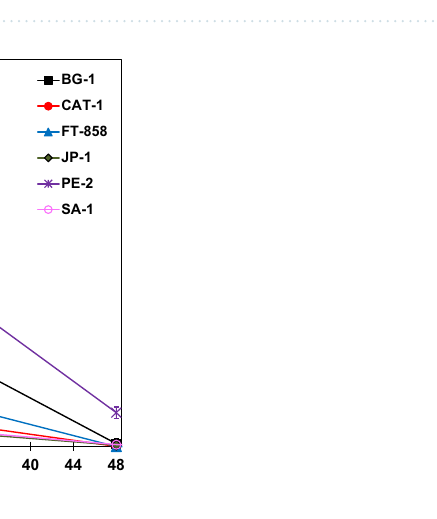
Figure 7. Glucose concentration profiles during BRS AG rice fermentations with S. cerevisiae strains. The error bar represents the standard deviation from the essays carried out in